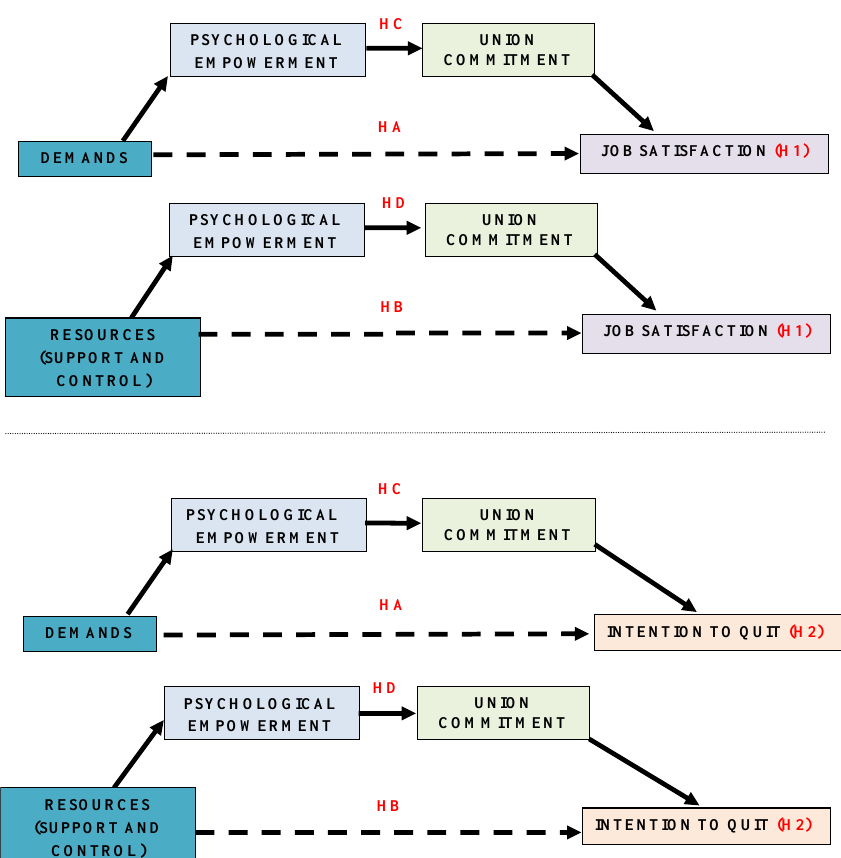
Figure 1. Hypotheses and proposed model. Note: HA: Job demands will be directly and negatively related to job satisfaction/intention to quit. HB: Work resources will be directly and positively related to job satisfaction/intention to quit. HC: The relation between demands and satisfaction/intention to quit will be multiply mediated by psychological empowerment and union commitment. HD: The relation between resources and satisfaction/intention to quit will be multiply mediated by psychological empowerment and union commitment.